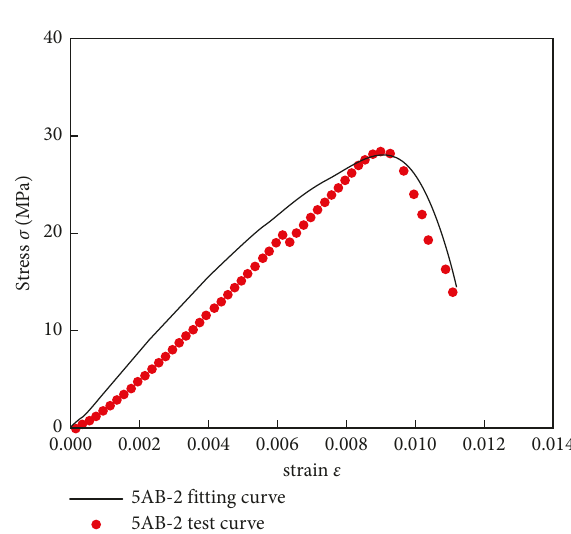
Figure 18: Test and fitted stress-strain curve of 5A-2.